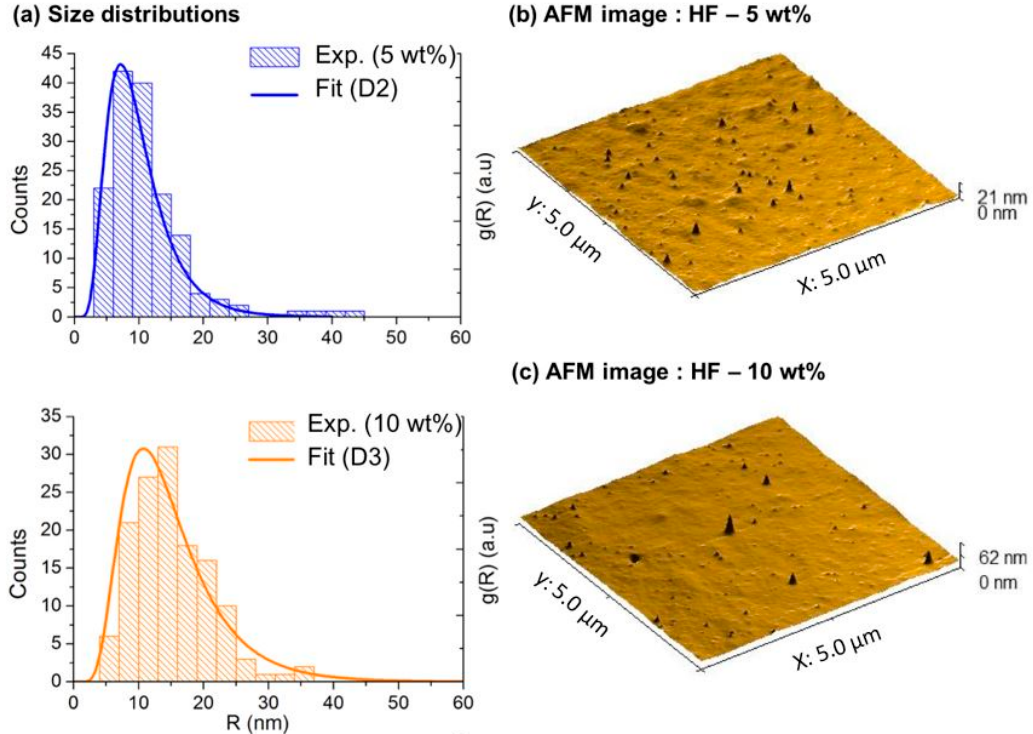
Figure 4. ( a ) Histogram and fitted size distribution of the HFs at 5 wt % and 10 wt %; ( b ) 3D view of typical AFM images of these samples.